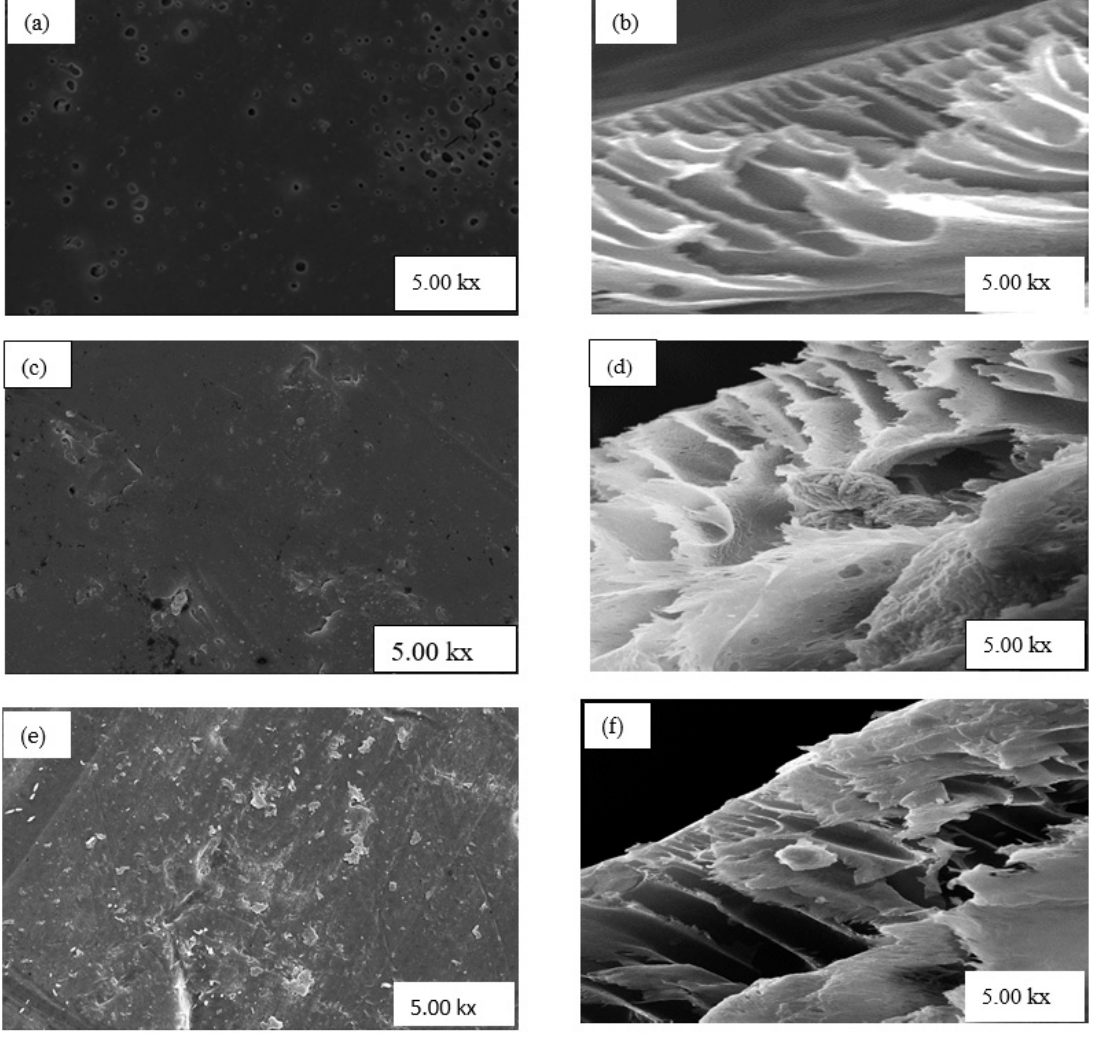
Figure 4. SEM images ( a , b ) show surface and cross-section of 0 wt.% NPs/polysulfone (PSF), ( c , d ) show surface and cross-section of 10 wt.% HSOD/PSF, and ( e , f ) show surface and cross-section of 10 wt.% SSOD/PSF, respectively.